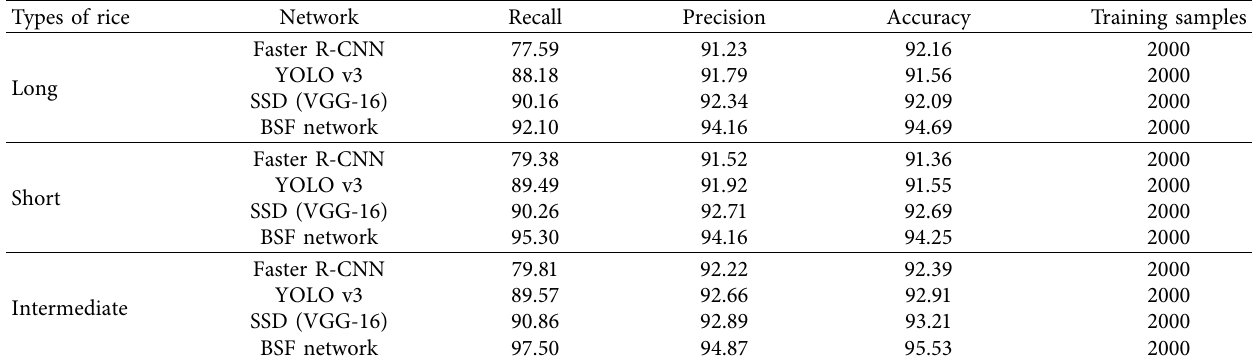
Table 8: Contrast test results.